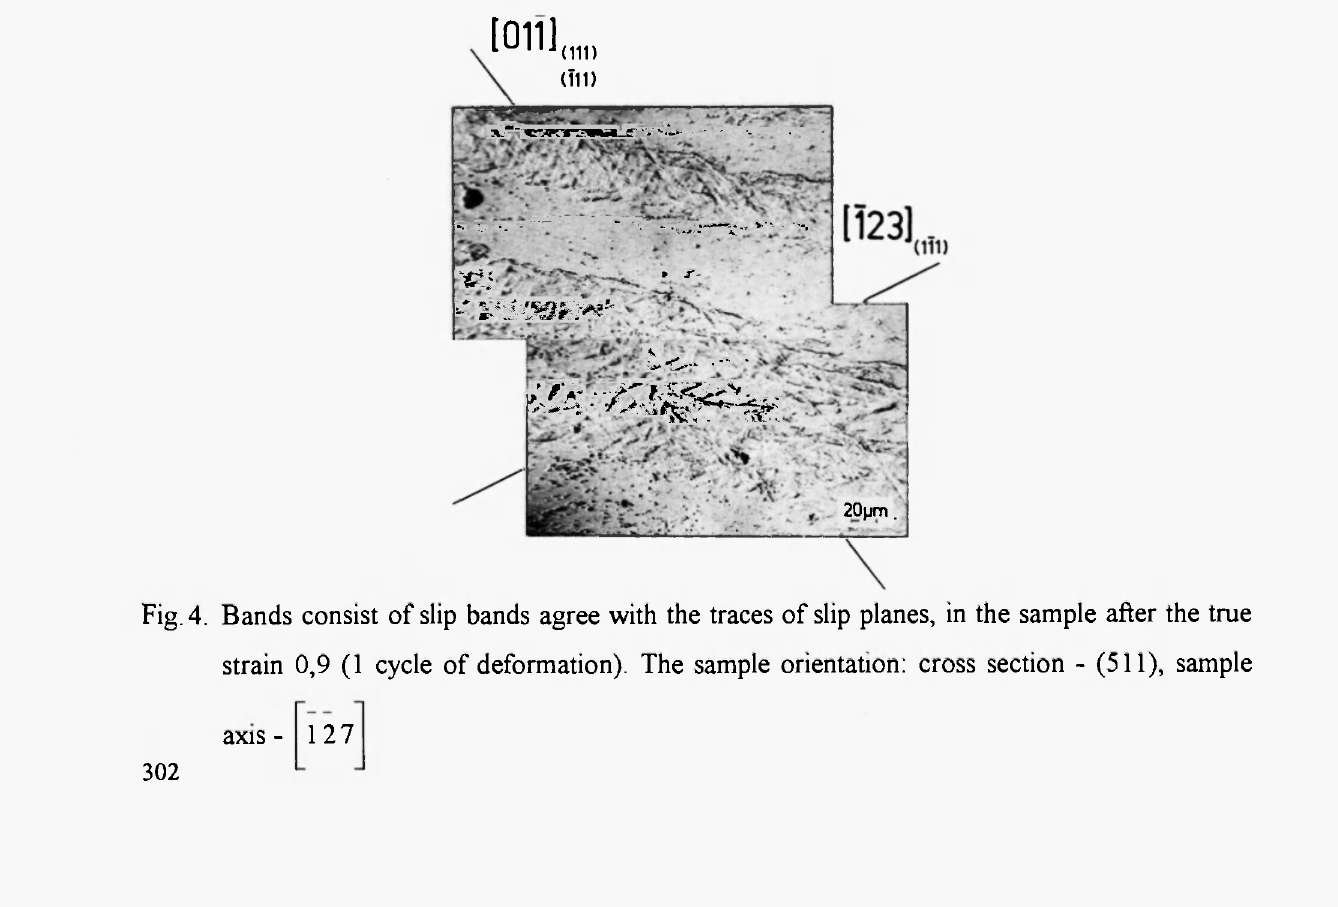
Fig.3. The cross section of monocrystal after the true strain 3,6 (4 cycles of deformation). The bands show differentiate inclination to the sample axis and short range of penetration, limited to the part of cross sample section.